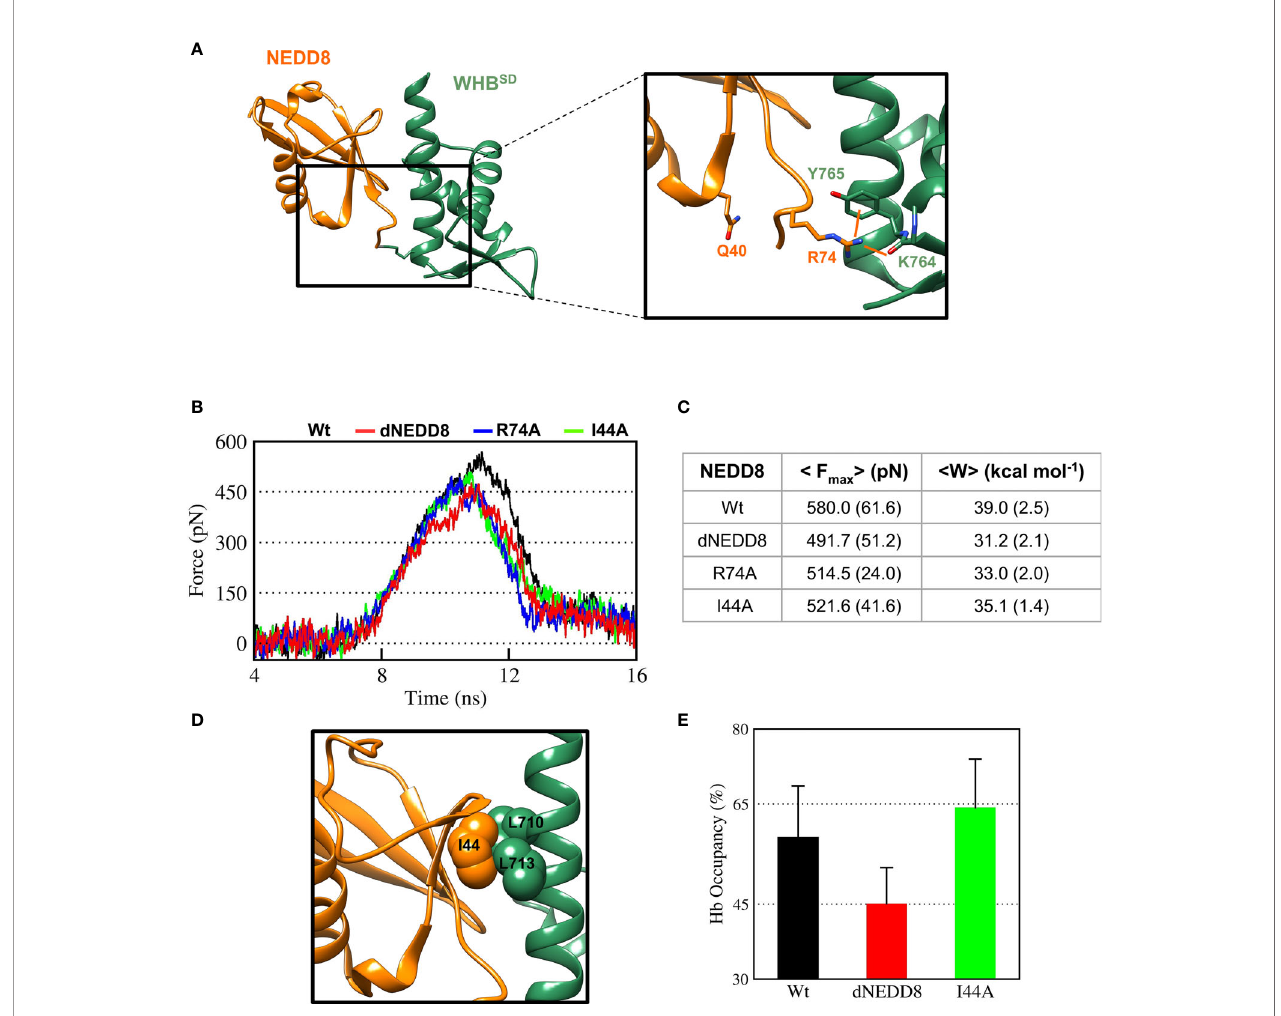
FIGURE 6 | Deamidation of NEDD8 enhances its dissociation from WHB SD . (A) R74-mediated interactions in the Cul5-WHB SD ~NEDD8 complex (PDB: 3DQV). Orange lines indicate interactions of R74 with and K764 (backbone) and Y765 (sidechain). (B) Mean force-time pro fi le for the dissociation of NEDD8-wt and its mutants from WHB SD obtained from steered MD (SMD) simulations. Twelve independent SMD runs were performed for 20 ns in the case of each complex. (C) F max and unbinding work (W) determined from average pro fi les obtained by steered MD. One standard error of mean is indicated in ( ). (D) I44-mediated hydrophobic interactions in the Cul5-WHB SD ~NEDD8 complex. (E) Mean occupancy of the R74-K764 hydrogen bond from NEDD8-wt, dNEDD8, and NEDD8-I44A SMD